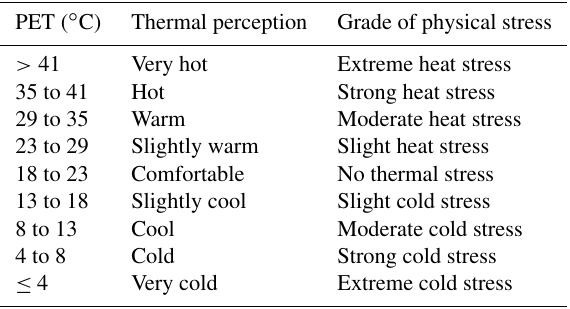
Table 3. Thermal sensation classes for human beings in central Eu- rope (with an internal heat production of 80W and a heat transfer resistance of the clothing of 0.9 clo (clothing value)) modified after Matzarakis and Mayer (1996).